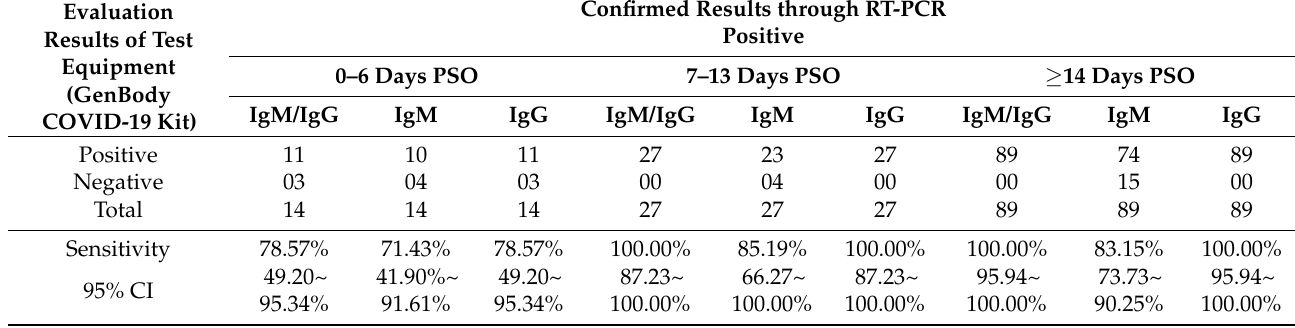
Table 5. Clinical sensitivity and specificity based on days